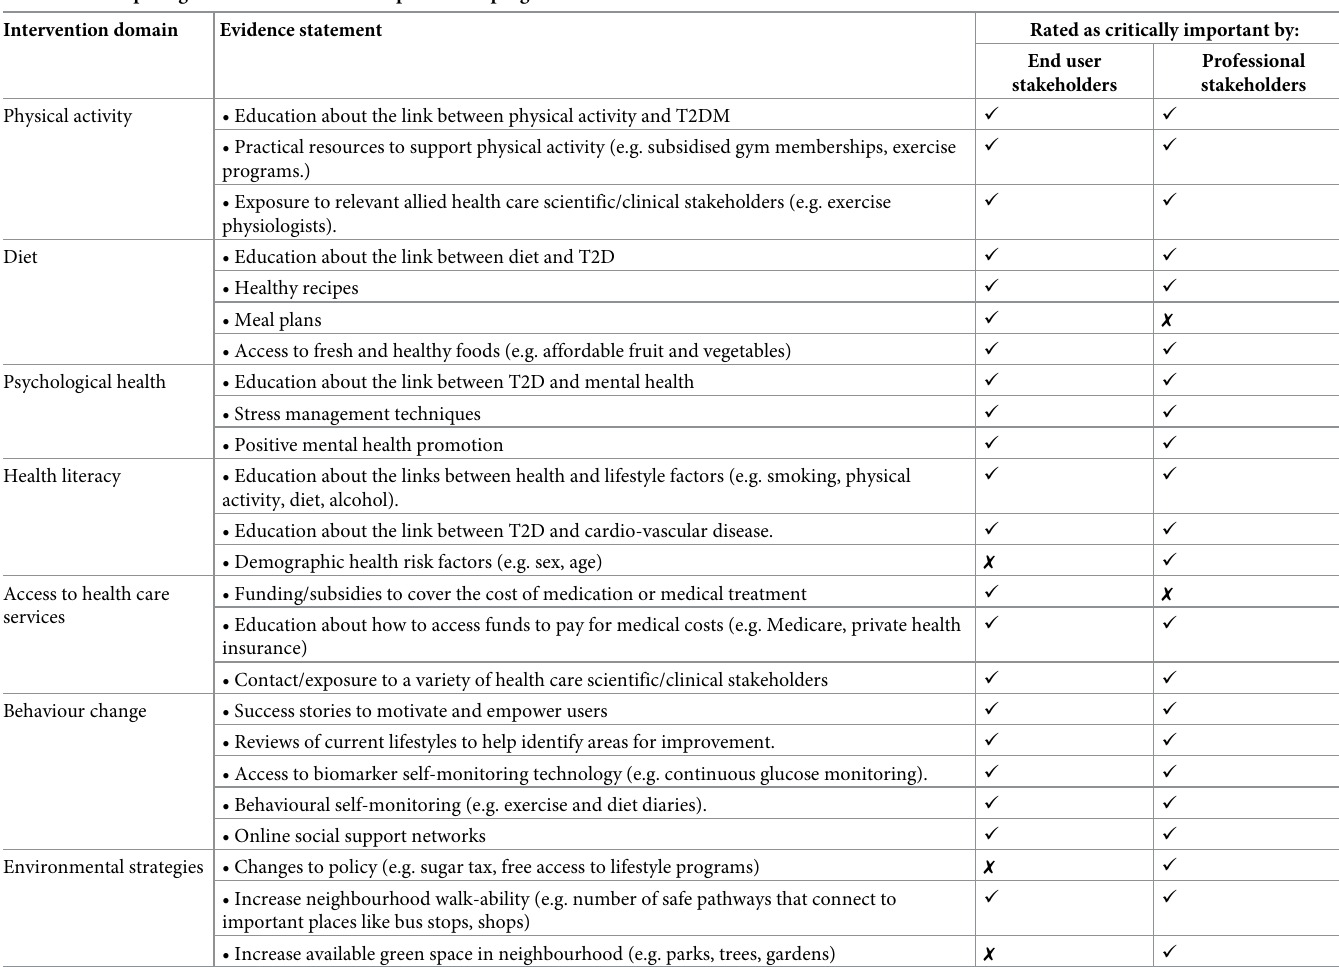
Table 2. Participant-generated ideas for health promotion